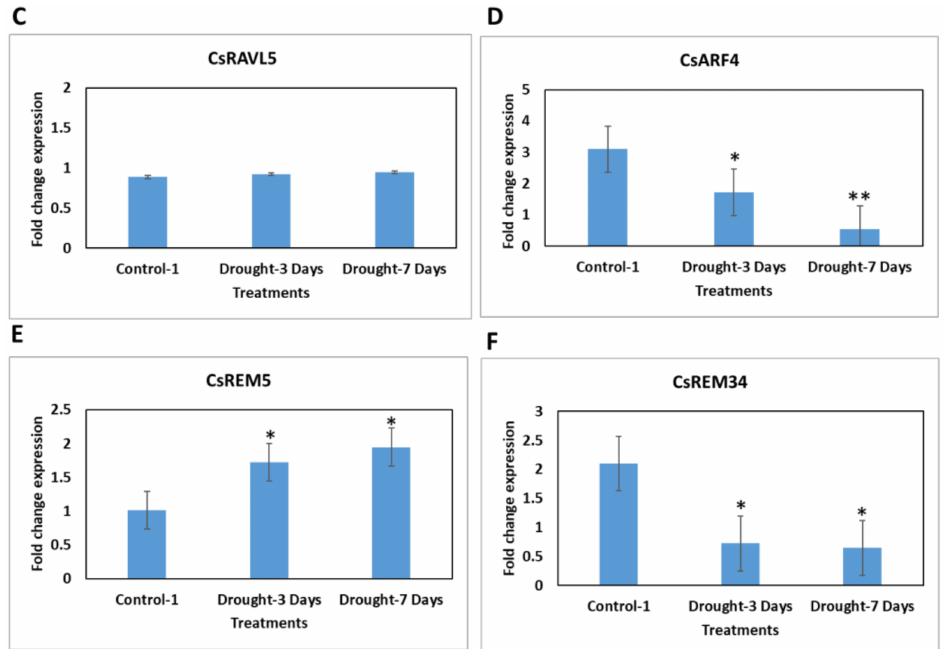
Figure 6. The B3 superfamily’s relative qRT-PCR test in response to drought. To produce an objective average value, the experiment was conducted in triplicate. In untreated plants, each gene had a default expression value of 1. Bars have been placed in each column. * displays the significance of the PCR results, and ** shows the most significant results. ( A ) The gene expression of CsREM17. ( B ) The gene expression of CsARF10. ( C ) The gene expression of CsRAVL5. ( D ) The gene expression of CsARF4. ( E ) The gene expression of CsREM5. ( F ) The gene expression of